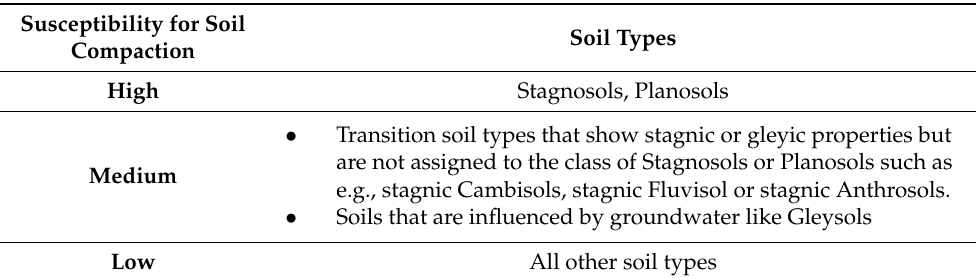
Table 2. Classification of soil types regarding their susceptibility for soil compaction during harvest- ing operations of silage